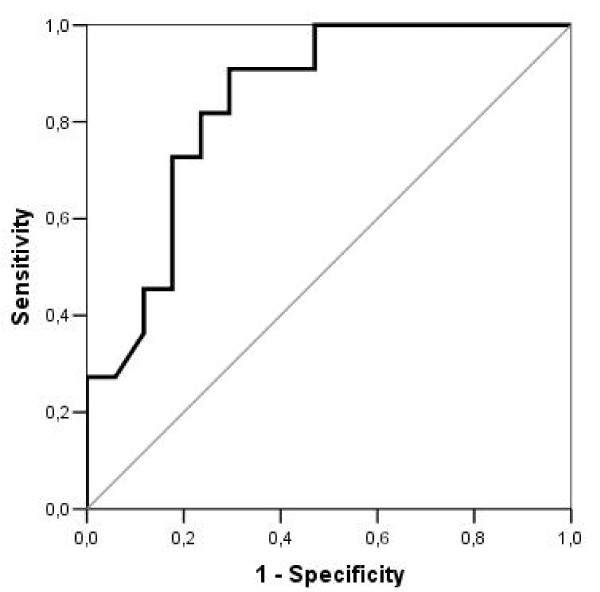
Diagram of ROC curves for patients who received long course of radiotherapy. Area 84.2%; p = 0.003.